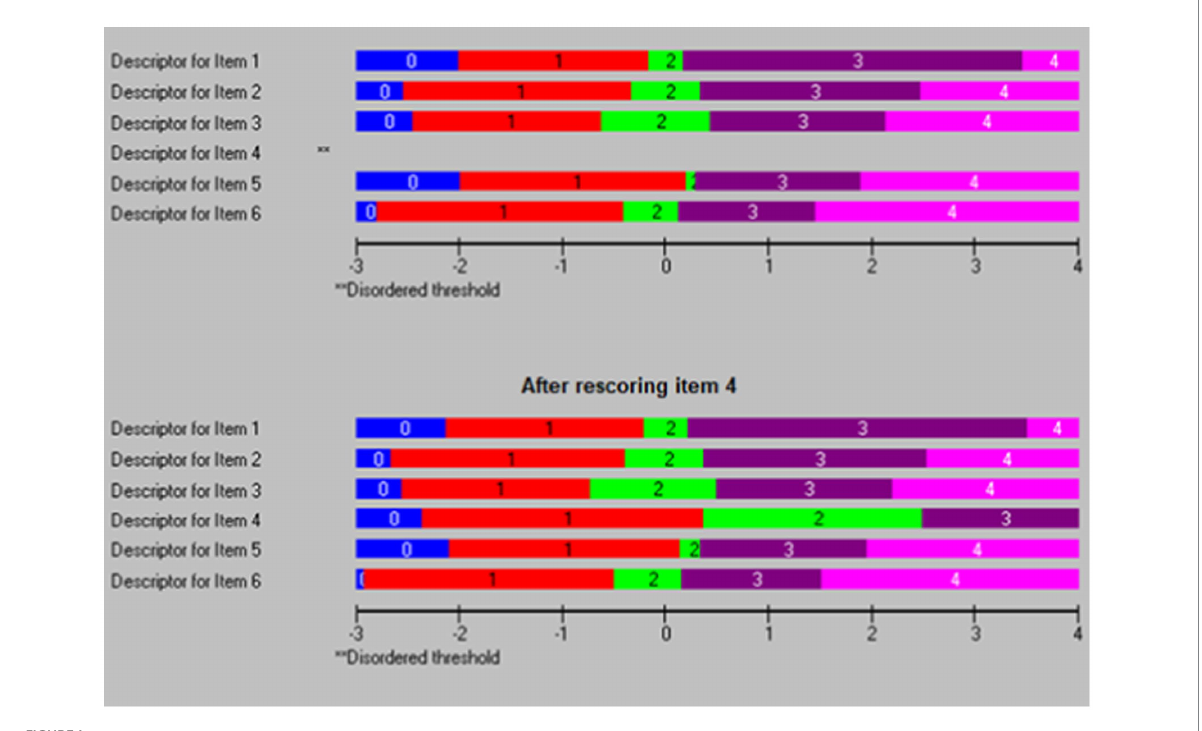
FIGURE 1 Thresholds map for family interaction before (top chart) and after rescoring of item 4 (bottom chart).